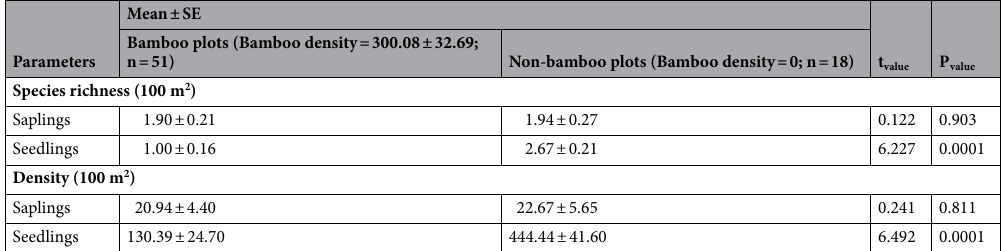
Table 3. Comparison of species richness and density of saplings and seedlings of trees between bamboo and non-bamboo plots. Mean values ± SE of the vegetation parameters calculated and compared between bamboo and non-bamboo plots using t-test for independence samples.